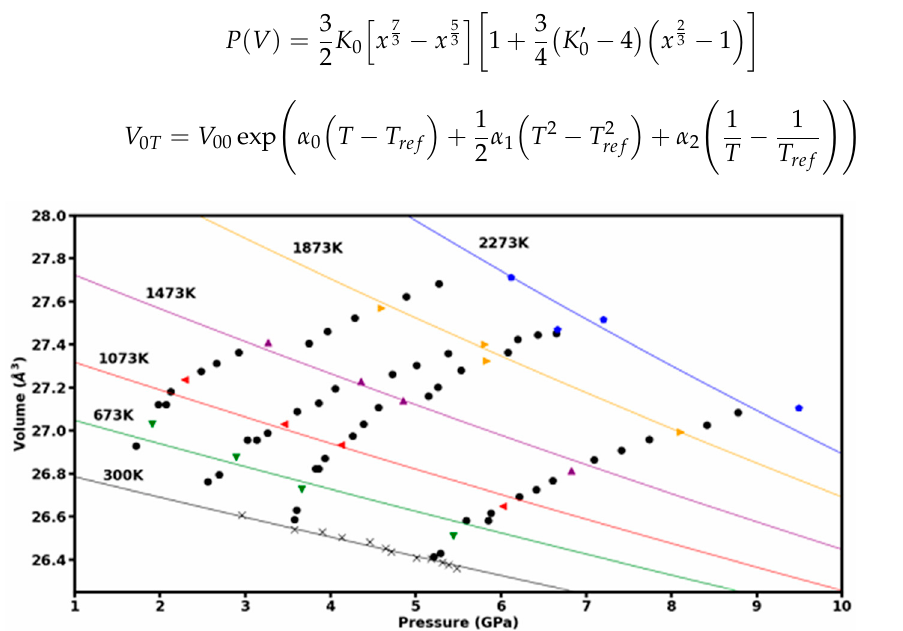
Figure 8. The measured Pressure–Volume–Temperature data for the (Hf, Mo, Nb, Ta, Ti)B 2 sample to 9.5 GPa and 2273 K. The “x” marked data points were taken during decompression at 300 K. The solid lines are fitted to various isotherms ranging from 300 to 2273 K. The thermal equation of state fit is described in the text.